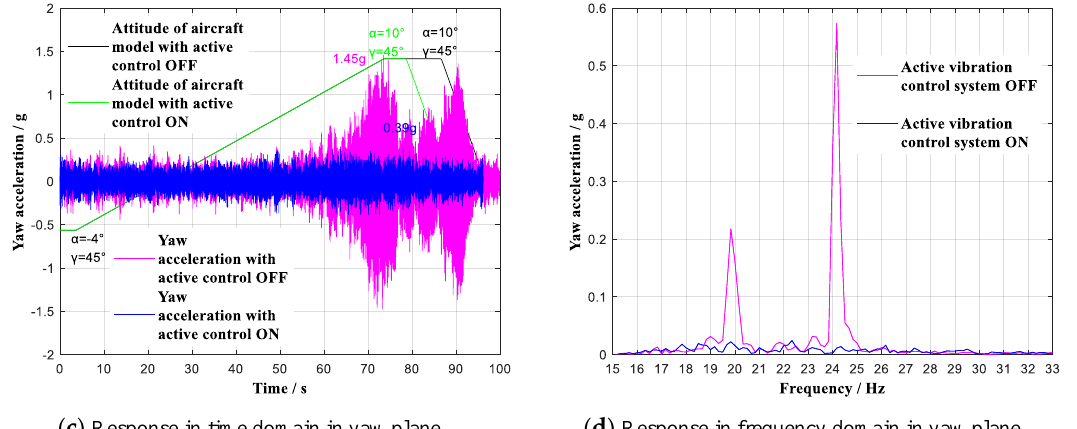
Figure 13. Vibration with multidimensional vibration suppression system off and on lifting continuous (γ = 45°) at 0.6 Ma. ( a ) Response in time domain in pitch plane; ( b ) Response in frequency domain in pitch plane; ( c ) Response in time domain in yaw plane; ( d ) Response in frequency domain in yaw plane.